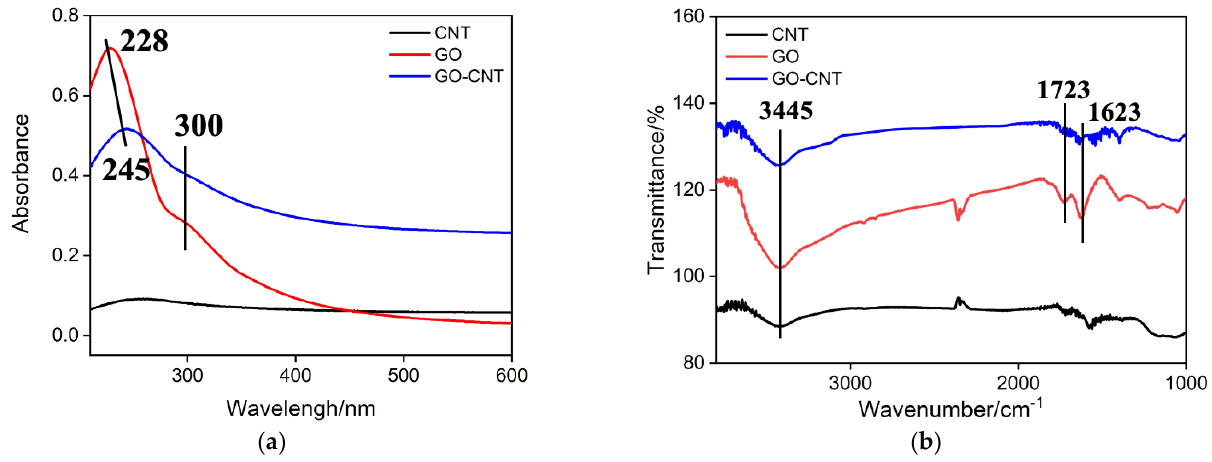
Figure 2. UV-Vis ( a ) and FTIR ( b ) spectra of the supernatant of CNT, GO, and GO-CNT nanocom- posite.